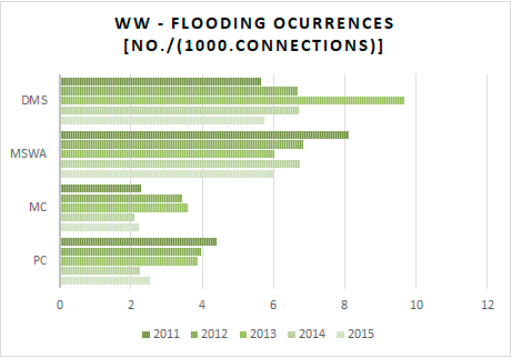
Figure 8. Evolution of floods in wastewater service.